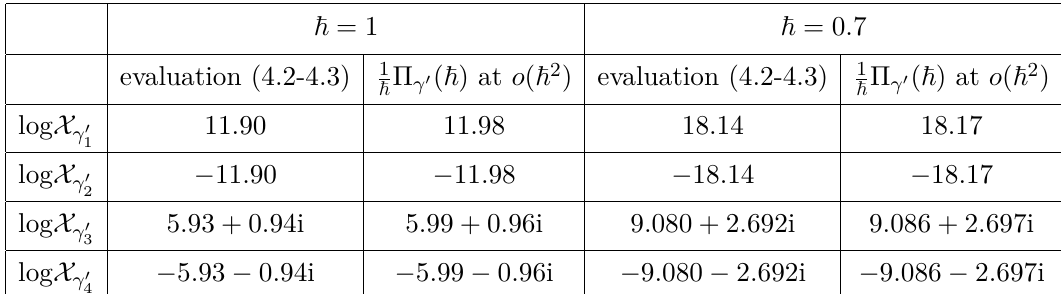
Table 5 . Comparison of log X γ 0 with the formal quantum periods expansion up to order- ~ 2 for equation A of (1.12) at ~ = 1 and ~ = 0 . 7 , where we have set u ~ = 1 ~ = 0 . 7